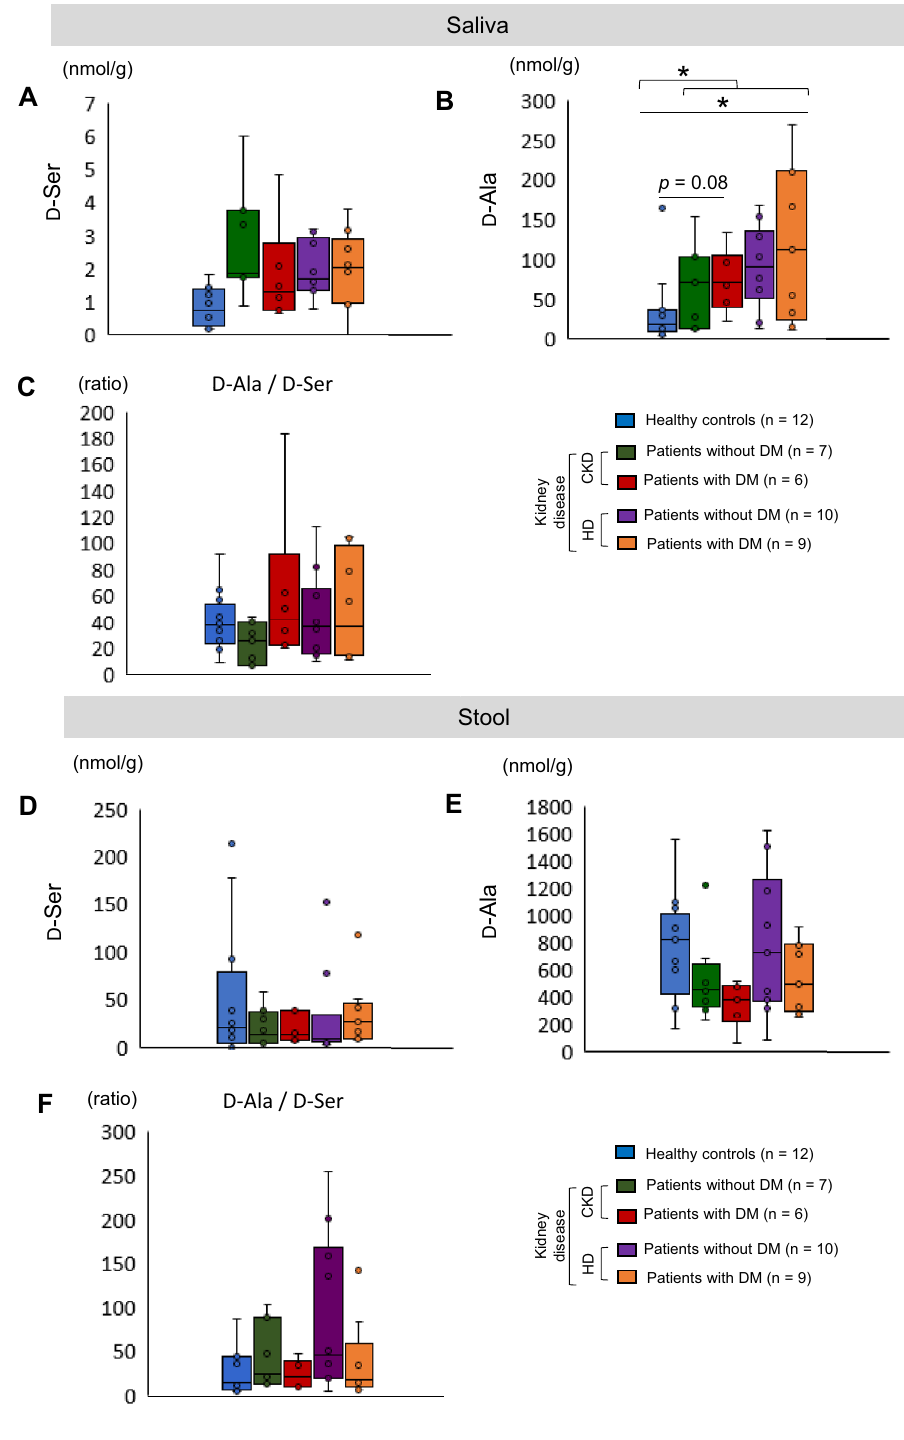
Figure 2. Salivary and stool d-alanine (D-Ala) and D-serine (D-Ser) levels. ( A ) D-Ser and ( B ) D-Ala levels ( C ) D-Ala/D-Ser ratio in saliva samples from healthy controls and patients with kidney diseases. ( D ) D-Ser and ( E ) D-Ala levels ( F ) D-Ala/D-Ser ratio in stool samples from healthy controls and patients with kidney diseases. One-way ANOVA and a t -test were used for statistical analysis. CKD chronic kidney disease, DM diabetes mellitus, HD